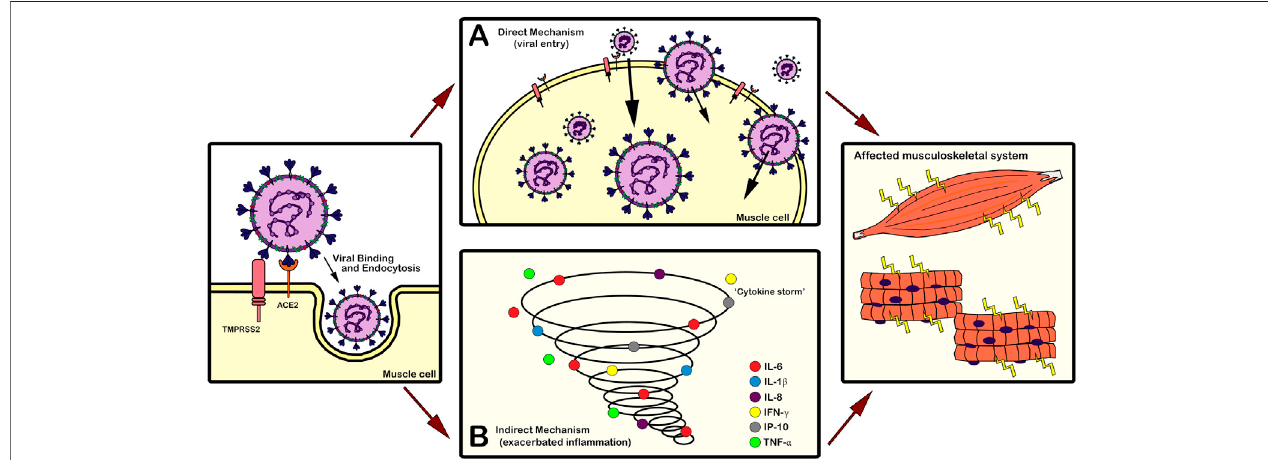
FIGURE 2 | Mechanisms of action of SARS-CoV-2 on the skeletal muscle tissue. (A) Direct mechanism via SARS-CoV-2 binding to receptors on the skeletal musclecellsurfaceandentryofthevirusintothecell.SeveraltypesofmusculoskeletalcellsexpressACE2and/orTMPRSS2,whichallowsthistypeofdirectmechanism of action of the virus. (B) Indirect mechanism considering the adverse effects of the elevated in fl ammatory process ( “ cytokine storm ” ) caused by SARS-CoV-2 infection on the musculoskeletal tissue. The deregulated release of cytokines and chemokines (IL-6, IL-1 β , IL-8, IFN- γ , IP-10, TNF- α ) by the immune system results in exacerbated in fl ammation that can lead to multi-organ injuries. Both mechanisms (A , B) can affect the musculoskeletal system, causing manifestations such as fatigue and myalgia in symptomatic COVID-19 individuals. ACE2: angiotensin-converting enzyme 2; IFN- γ : interferon-gamma; IL-1 β : interleukin-1 β ; IL-6: interleukin-6; IL-8: interleukin-8; IP-10: interferon-gamma inducible protein 10; TMPRSS2: transmembrane protease serine 2; TNF- α : tumor necrosis factor